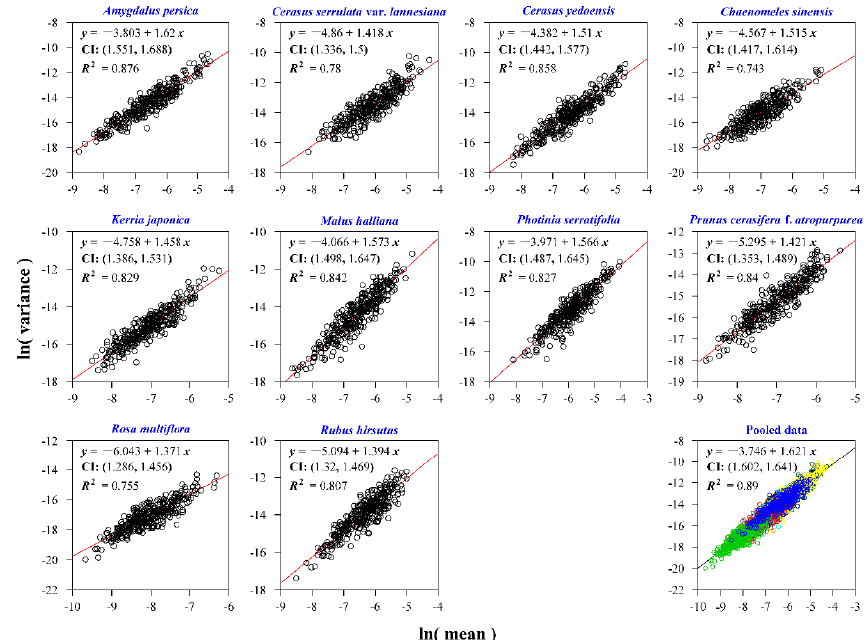
Figure 5. Taylor’s power law for the measure of leaf bilateral symmetry for 10 species of Rosaceae. The detailed Latin name and collecting information can be found in Table S3. The small open circles represent the observations, and the straight line represents the fitted regression line based on the ordinary least-squares method. ‘CI’ represents the 95% confidence interval of the estimate of the slope of the fitted linear equation.